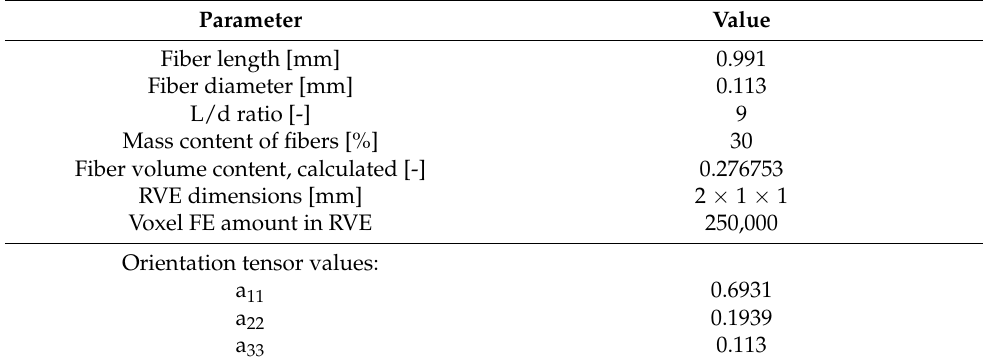
Table 6. RVE and hemp fibers geometry used in the